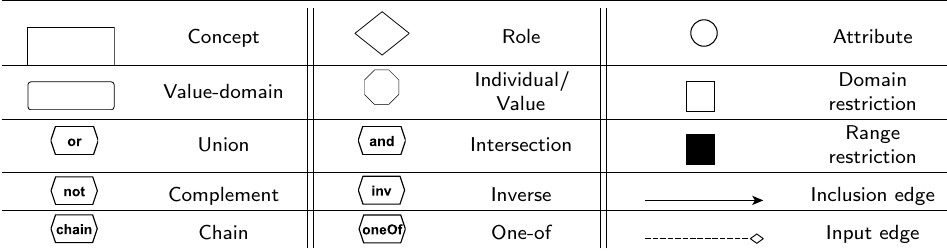
Figure 2. Nodes and edges in a G RAPHOL